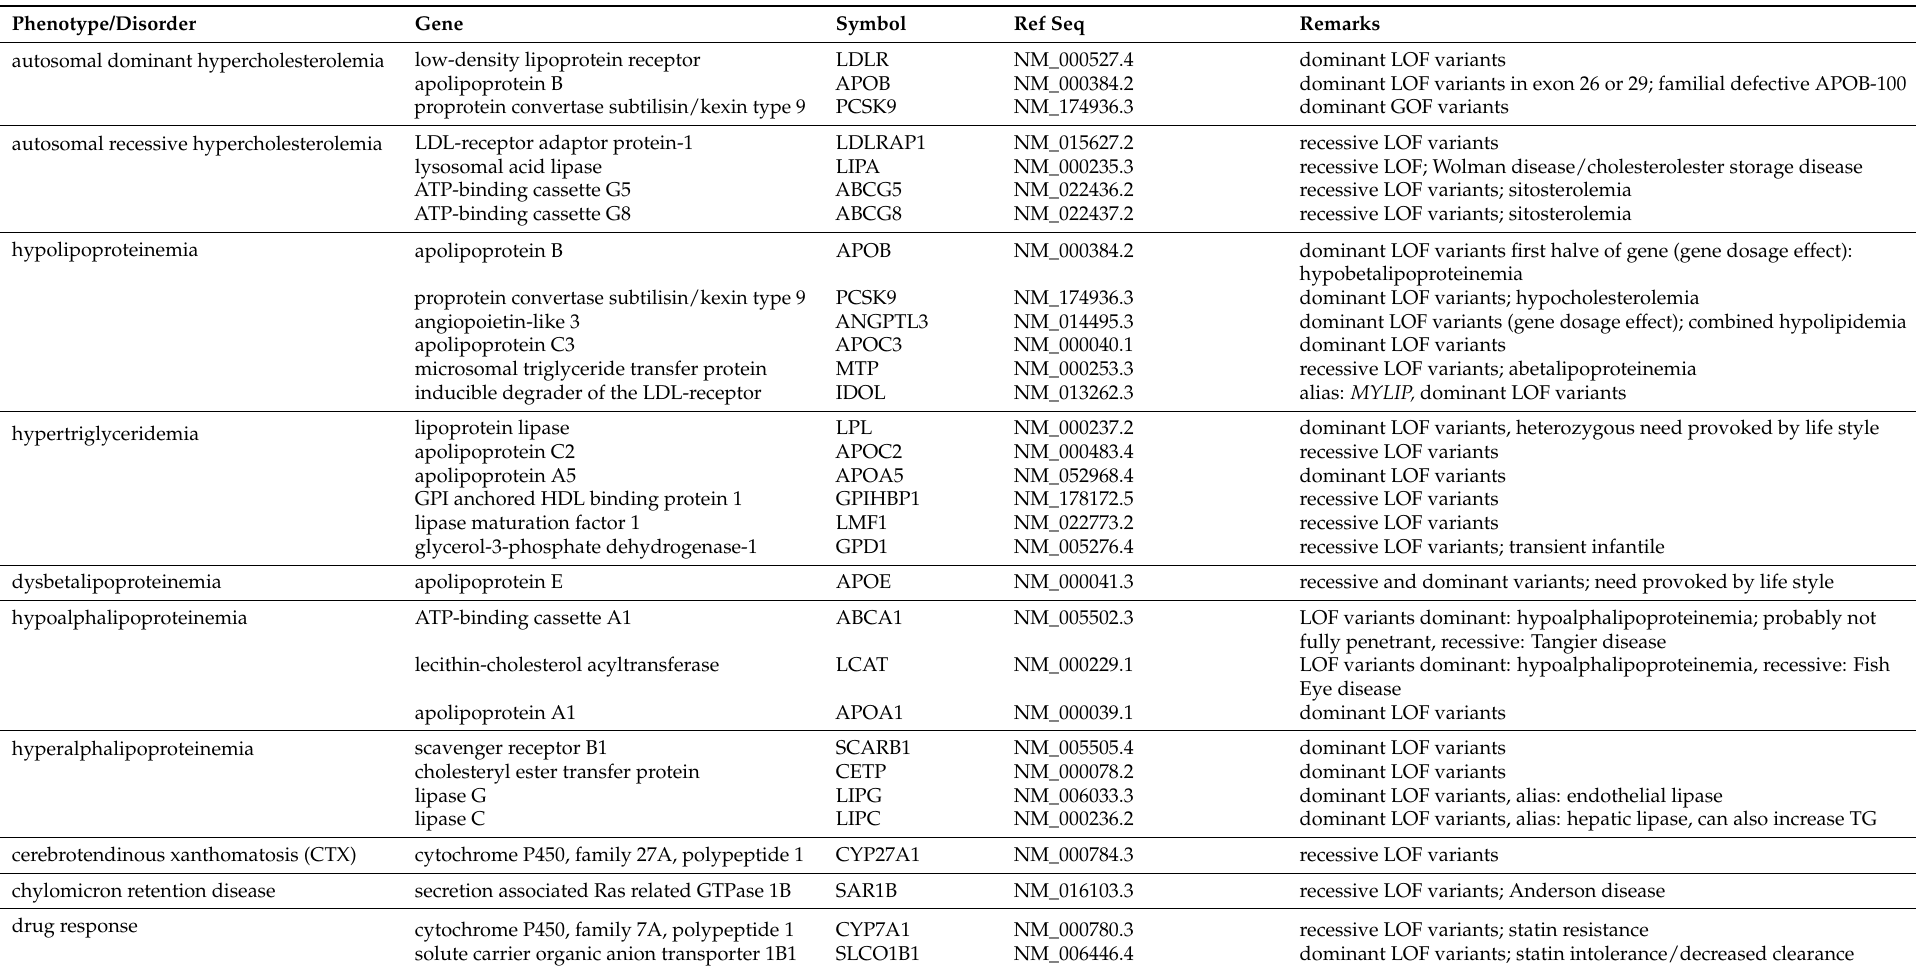
Table 1. Gene panel for NGS analysis of heritable dyslipidemias in the Netherlands. The panel is composed of 29 genes, of which 3 were FH-causing and 24 were causal for other dyslipidemias, and cover 10